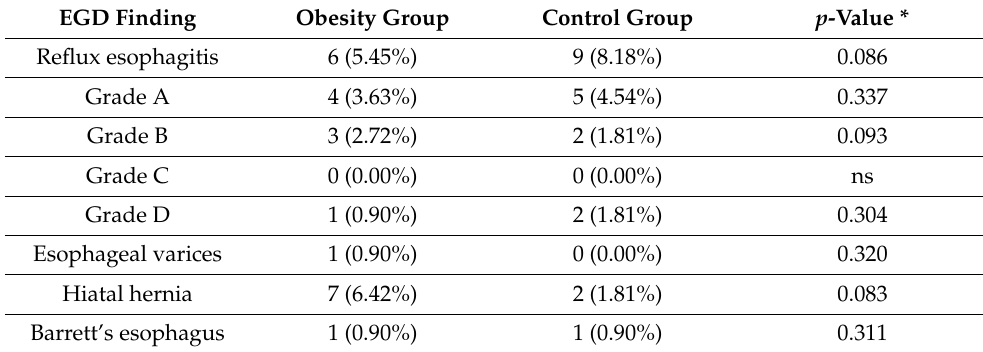
Table 2. Esophageal pathologies found via EGD in the study groups.